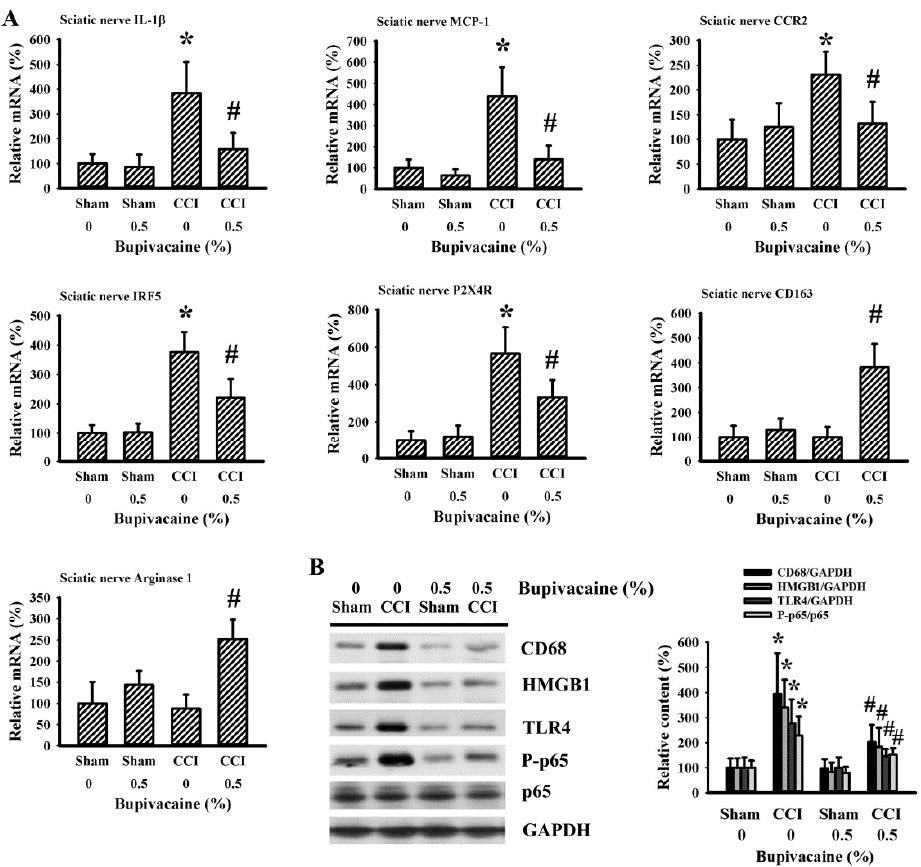
Figure 4. Bupivacaine alleviated inflammatory responses in the sciatic nerves of CCI rats. Rats were intrathecally injected with the indicated concentrations of bupivacaine (0 and 0.5%, diluted in saline) for 30 min prior to being subjected to sham and CCI operation. Seven days later, ipsilateral sciatic nerve tissues were collected and subjected to quantitative RT-PCR for the measurement of IL-1 β , MCP-1, CCR2, IRF5, P2X4R, CD163, and arginase 1 mRNA expression ( A ). Protein content of CD68, HMGB1, TLR4, P-p65, p65, and GAPDH was measured in the ipsilateral sciatic nerve tissues using Western blotting. Representative blots and quantitative results are shown ( B ). * p < 0.05 vs. sham/saline group and # p < 0.05 vs. CCI/saline group, n = 6.